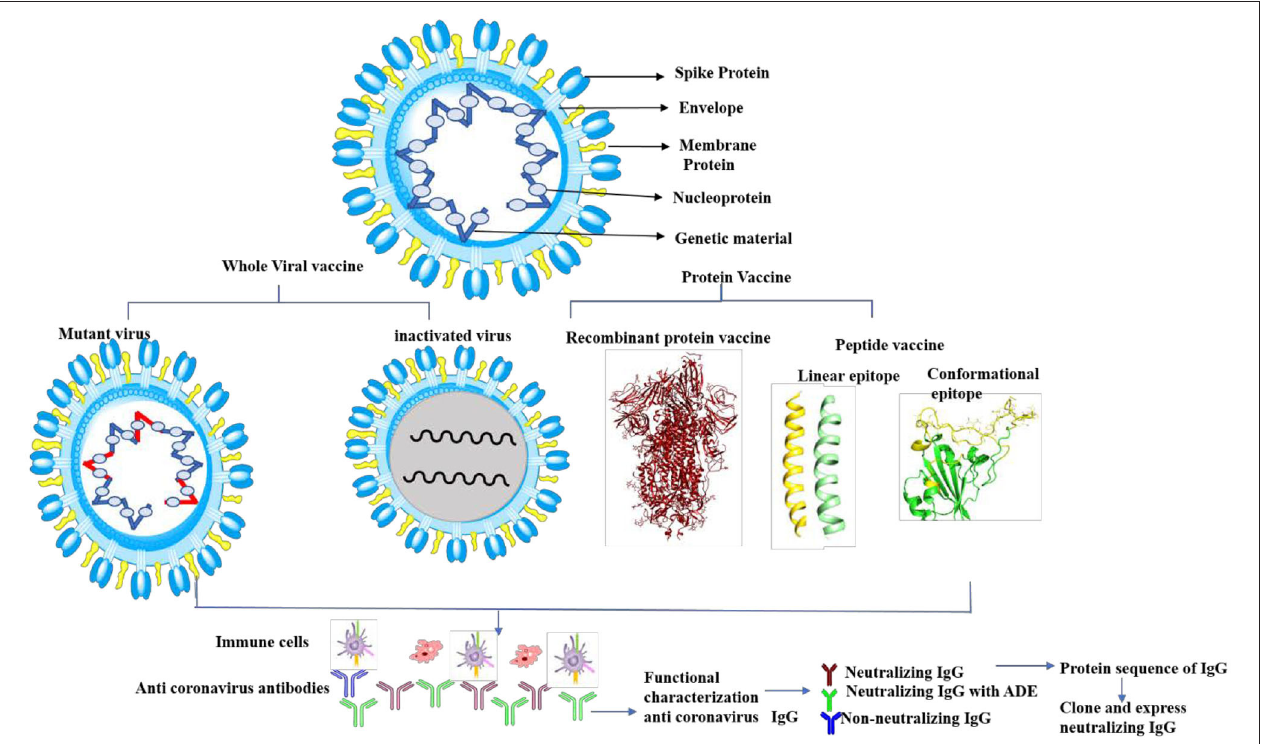
FIGURE 6 | Cartoon diagram shows the proposed vaccine design by whole virus vaccine and protein-based approach. The whole virus vaccine approach, recombinant protein and peptide based antigenic epitopes can activate immune cells to produce anti-viral antibodies against SARS-CoV-2. The next step is functional characterization of these antibodies for viral neutralization properties and ADE activities. Neutralizing antibodies without ADE activity can be sequenced and cloned and expressed antibodies (with Fab and Fc region) or variable region of heavy (H) and light (L) chain to therapeutic